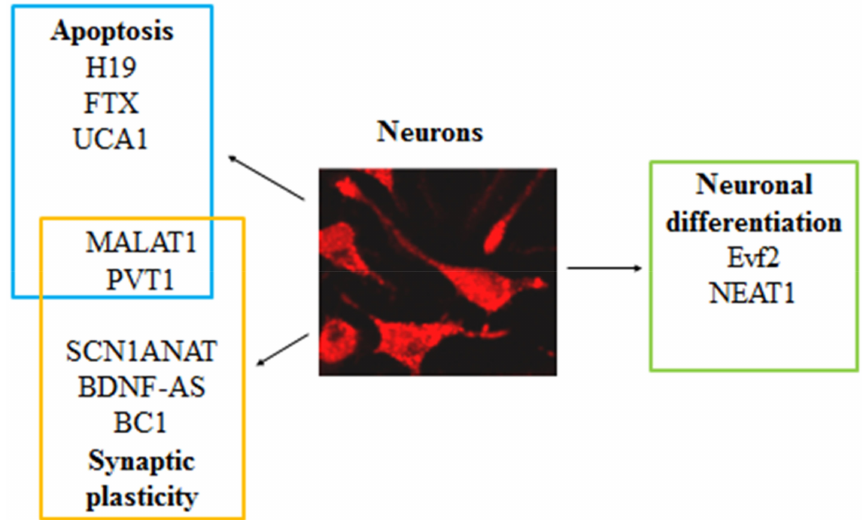
Figure 1. A summary of the most dysregulated lncRNAs in epilepsy. Each lncRNA is reported together with the biological process in which it has been